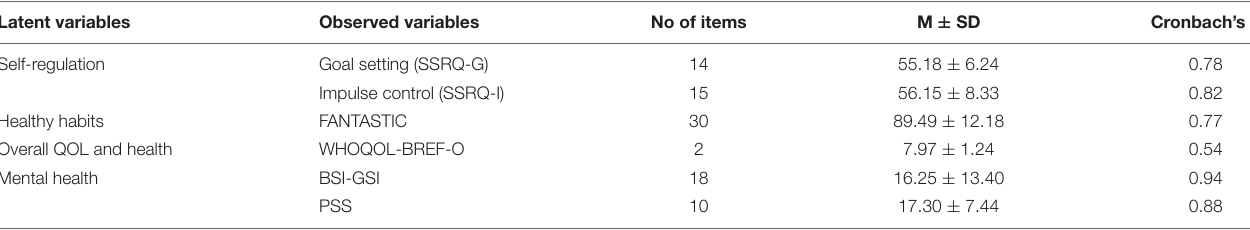
TABLE 3 | Descriptive Statistics and Cronbach’s alpha values for the variables included in the